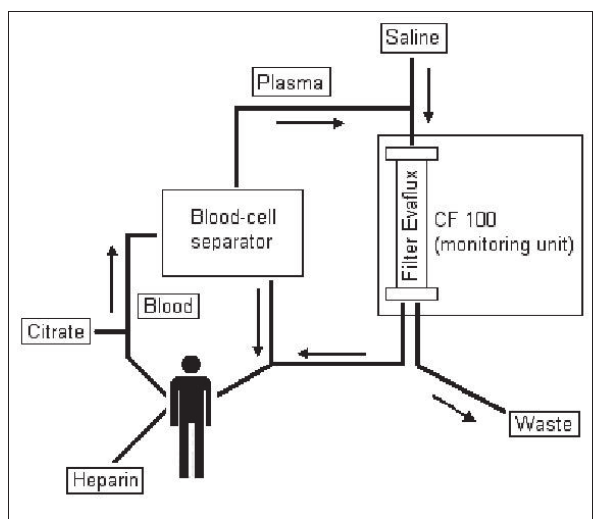
Fig. 1. Scheme of rheohaemapheresis with our